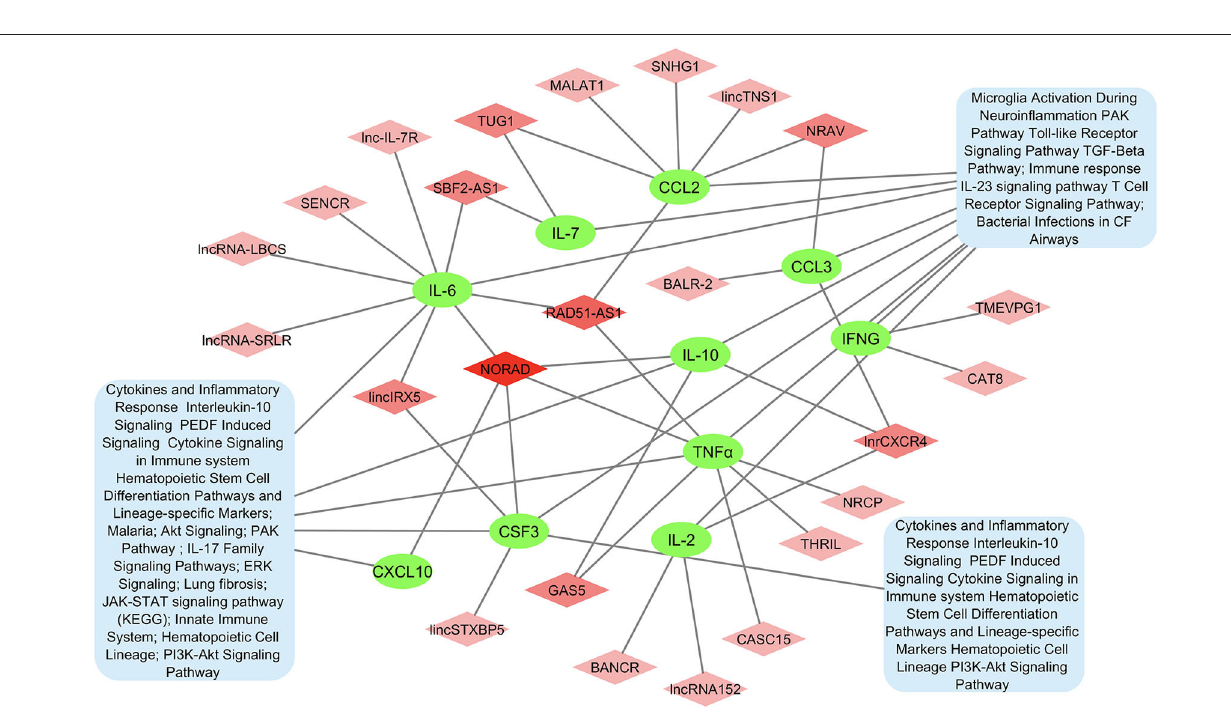
significant cytokines except for IFN γ are also involved in the pathways: Akt signaling, PAK pathway, and ERK